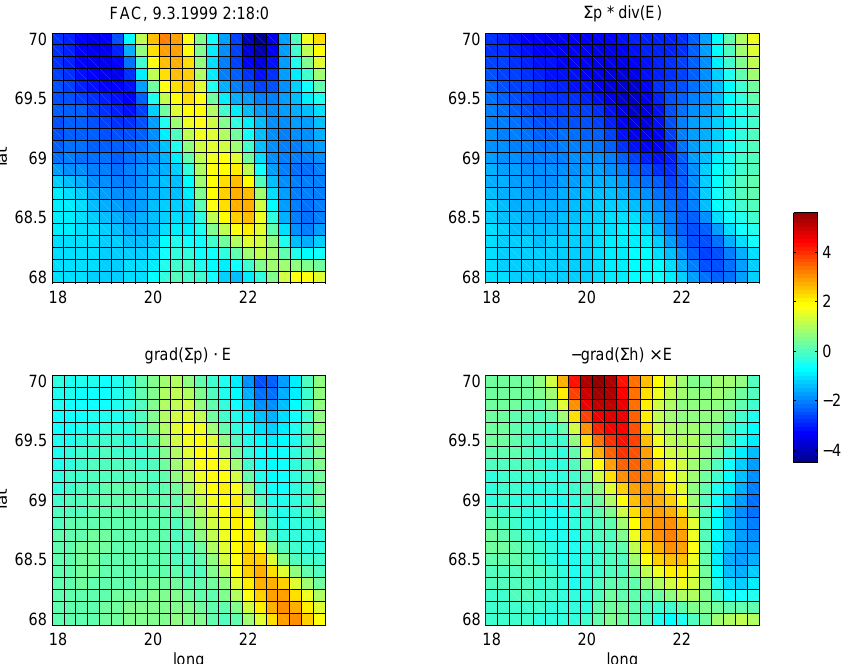
Fig. 11. Example of the total FAC and contributions from different terms. This snapshot corresponds to the situation illustrated in Fig.